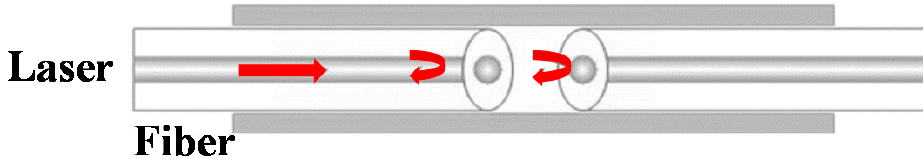
Figure 15. Schematic of the FPI.